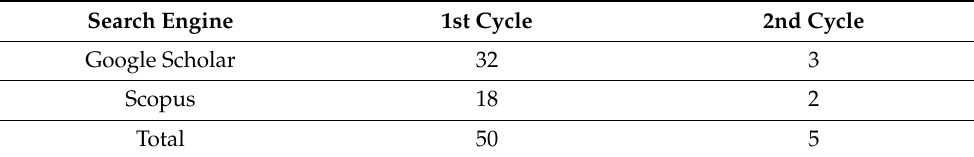
Table 2. Publications found by each search engine and selection of publications between the two cycles.